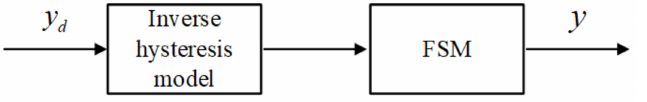
Figure 15. Hysteresis compensation with the inverse hysteresis